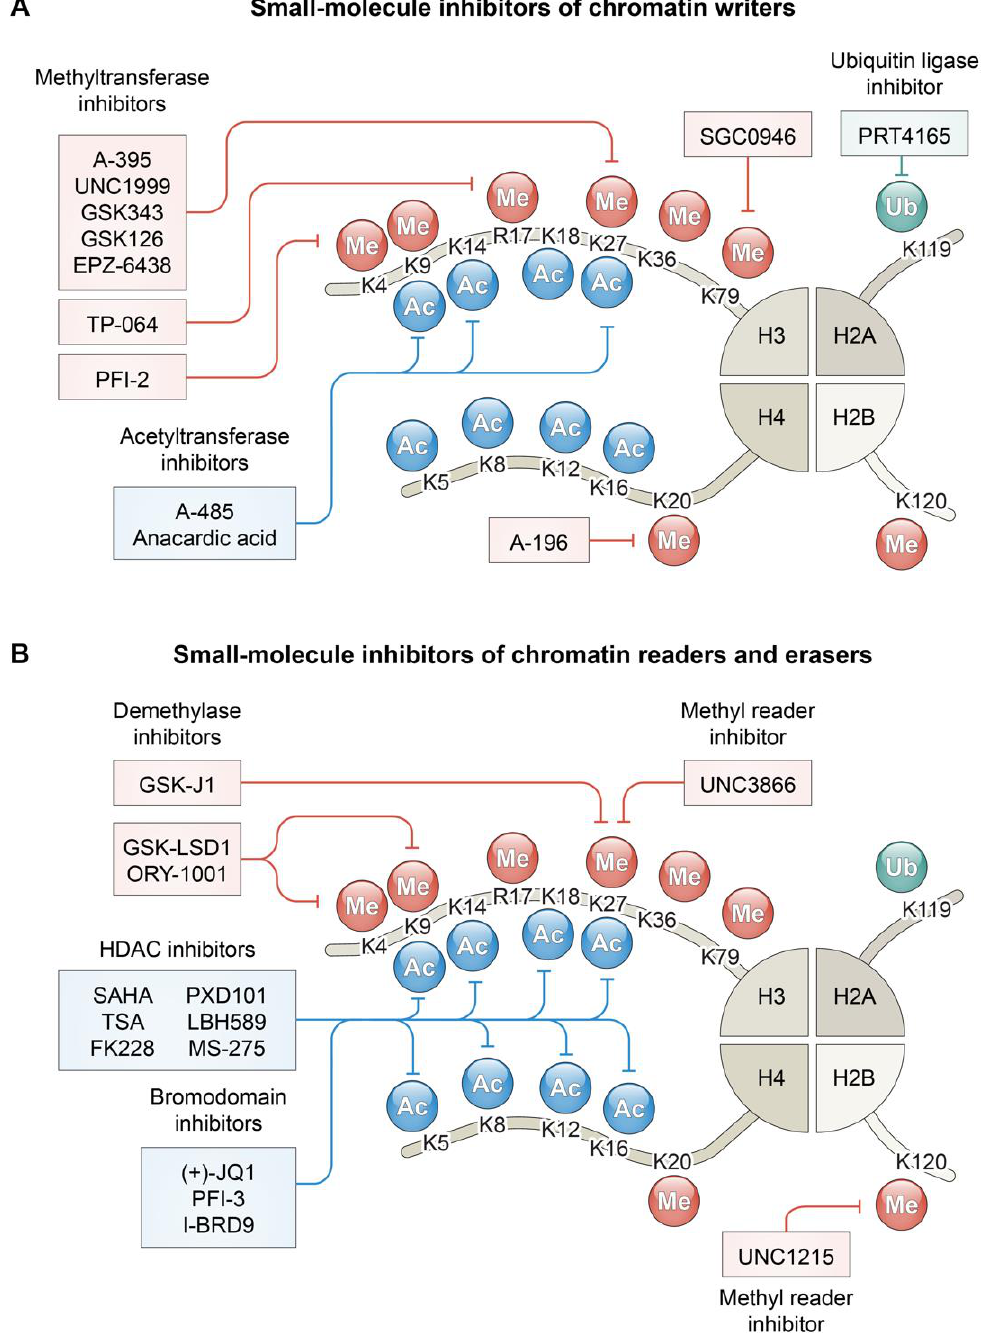
Figure 2. Small-molecule inhibitors of chromatin modifiers. ( A ) Drugs and chemical probes targeting writers of methyl, acetyl, and ubiquityl marks on histone tails; ( B ) Drugs and chemical probes targeting readers and erasers of these epigenetic marks.